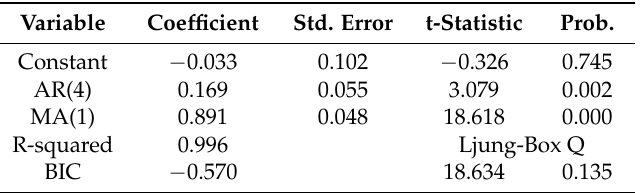
Table 6. Parameter estimation of ARIMA(4,1,1) model of CT48/2 station.